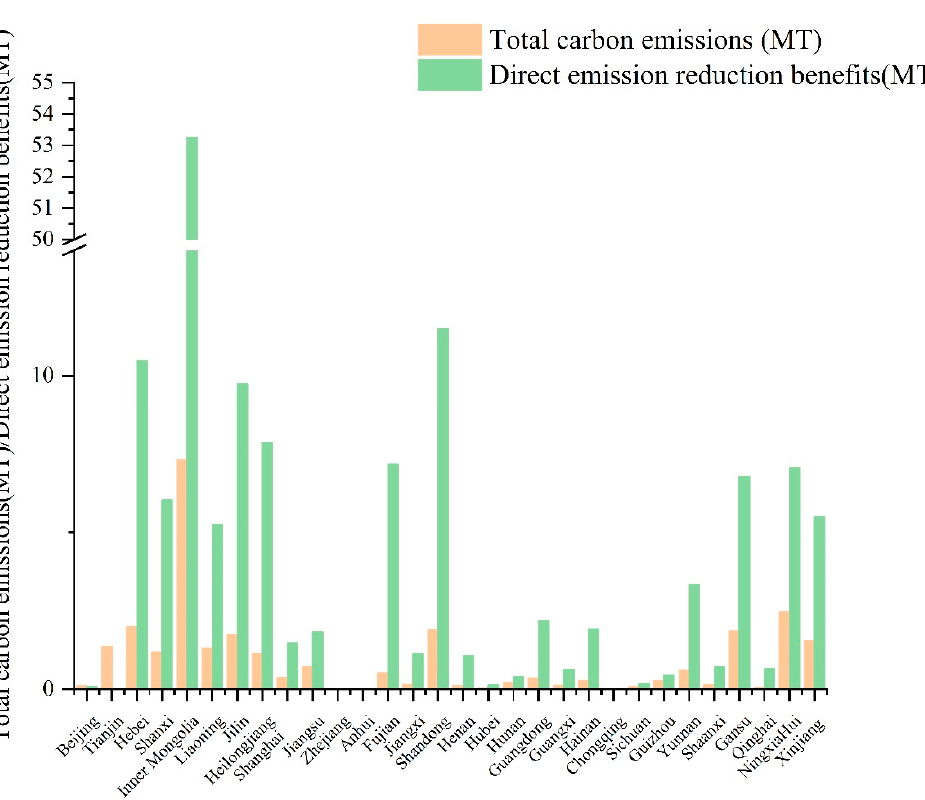
Figure 9. Emission reduction benefits of each province.